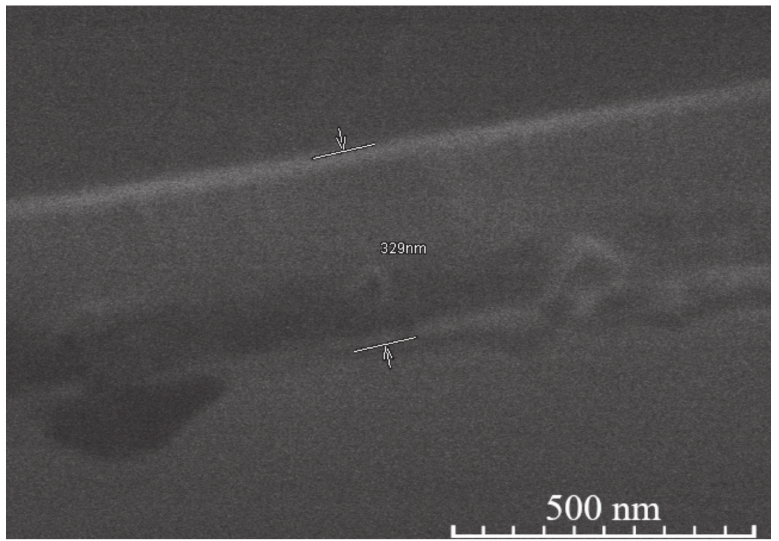
Figure 5. SEM micrograph of a cross-section of one 5-layer YIP sample, with example of thick- ness measurement. Table 1. Thickness of YIG, YIP, and TIP 15- and 5-layer